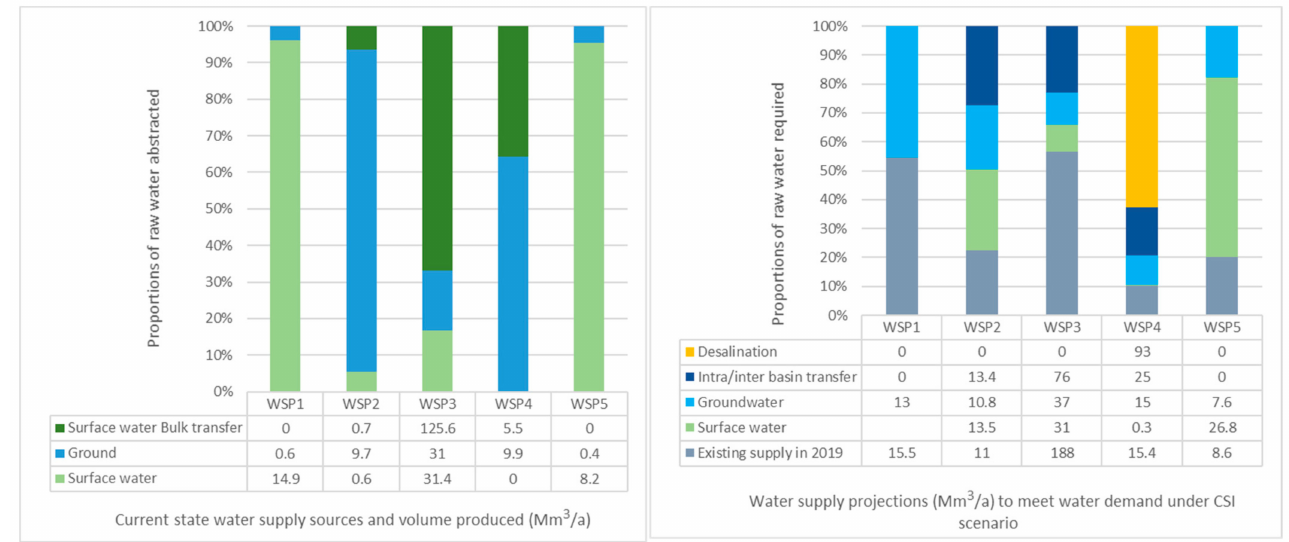
Figure 2. Comparison of current state water production and the projected supply needed to meet projected demand in 2030 under the Current State Improves ( CSI ) scenario (Projections assume service coverage to total population within service area to meet a per capita water demand of 120 L/p/d at 20% non-revenue water